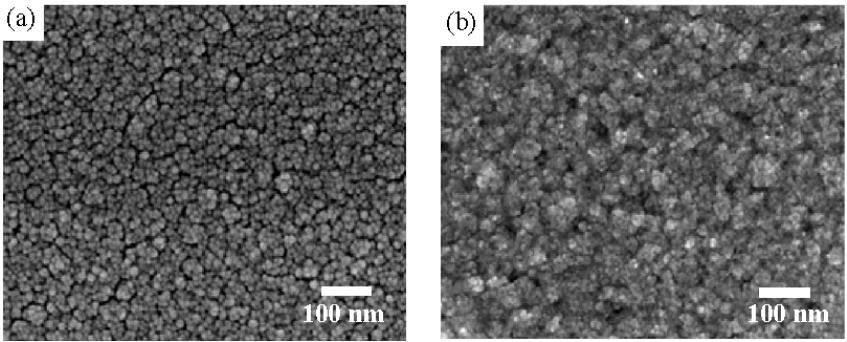
Figure 3. Surface morphologies of the ( a ) controlled TiO 2 film and ( b ) the NiO/TiO 2 nanocomposite structures annealed at 550